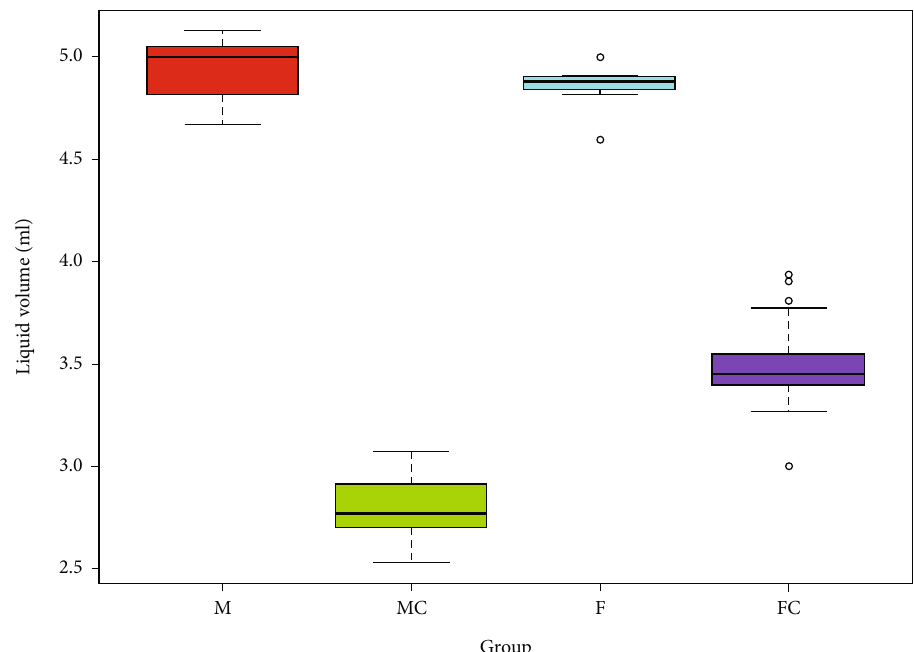
Figure 2: Comparison of distension volume threshold to reach AWR score = 3 among groups before NUCB2/Nesfatin-1 intervention. N = 8 per group.